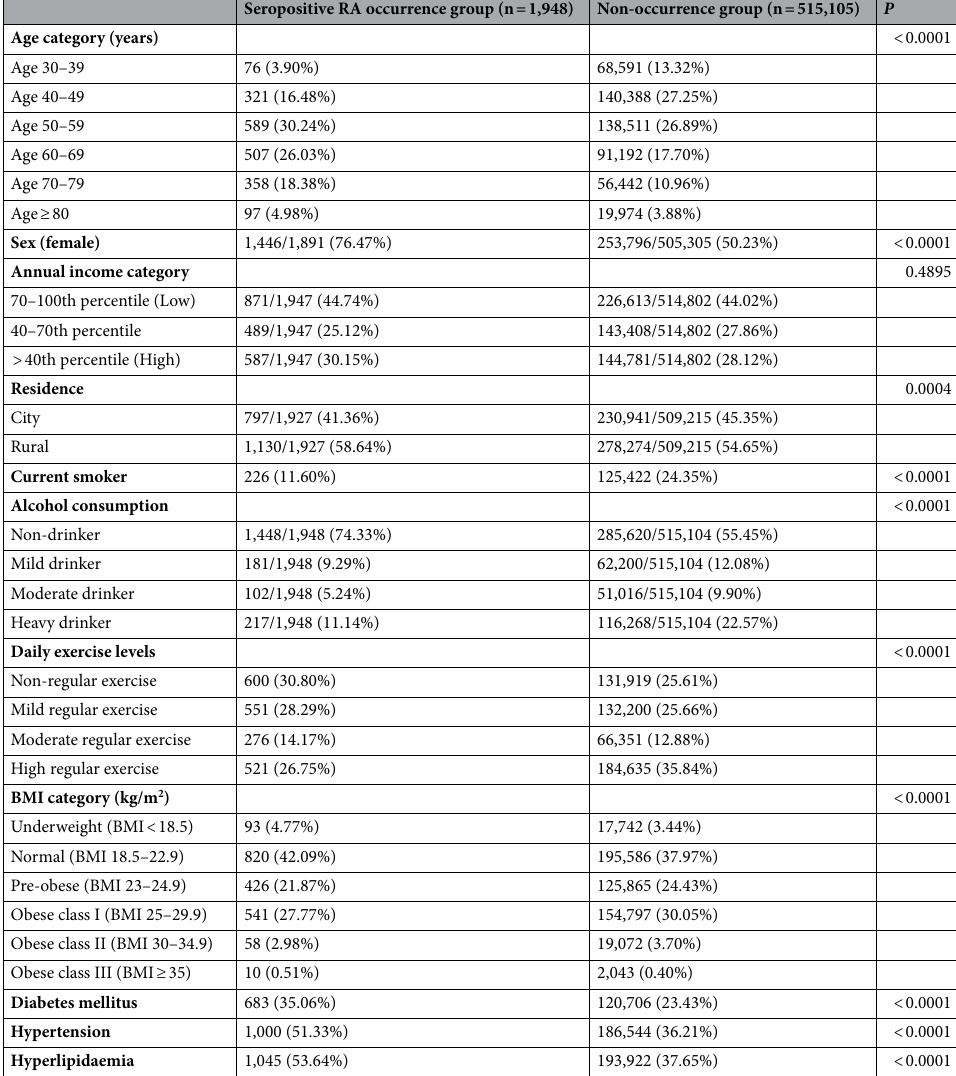
Table 1. Baseline characteristics of seropositive rheumatoid arthritis (RA) occurrence versus non-occurrence